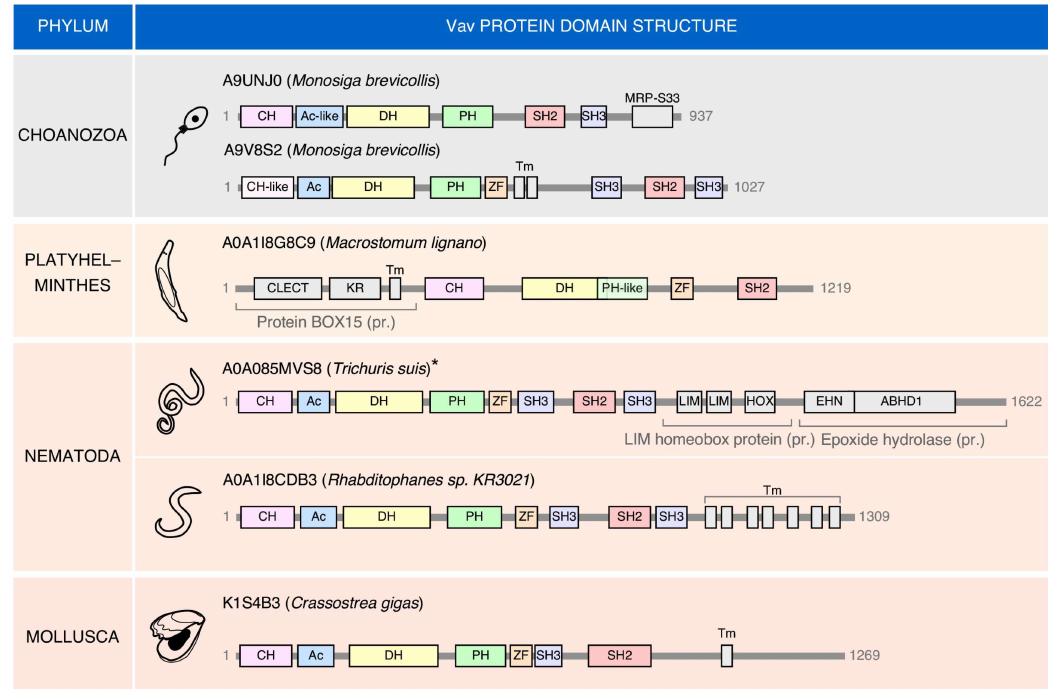
Figure 3. “Exotic” forms of Vav proteins found in invertebrate species.Depiction of the structure of Vav proteins in the indicated organisms (Uniprot accession codes are indicated for each